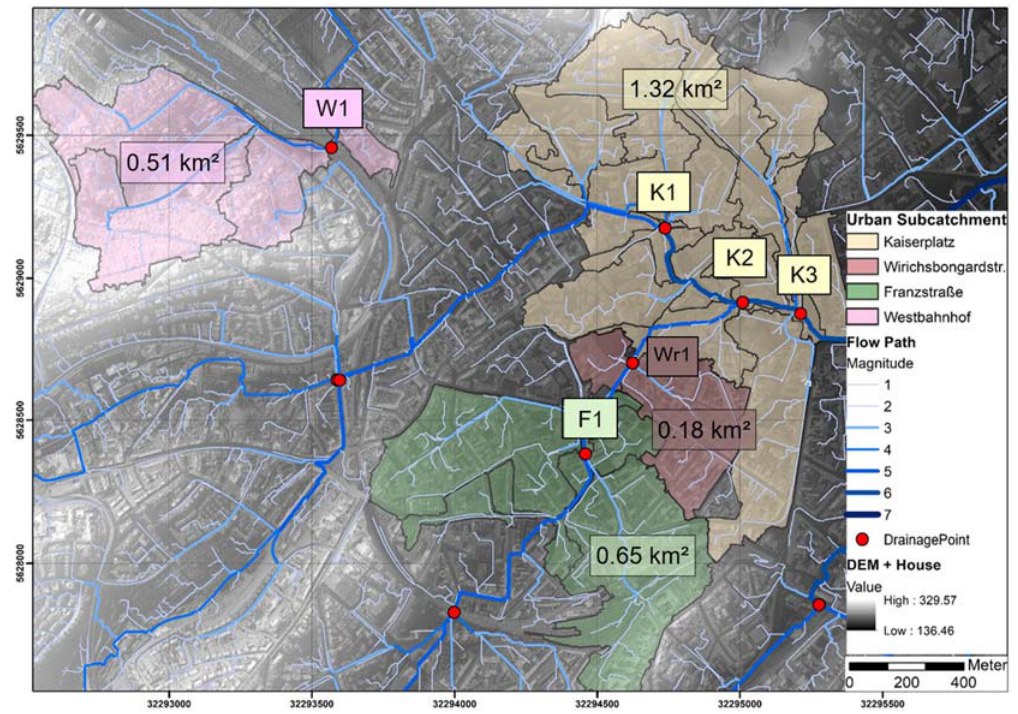
Figure 6. Determined urban subcatchments and catchment sizes including drainage points and flow paths in the study area of Aachen.